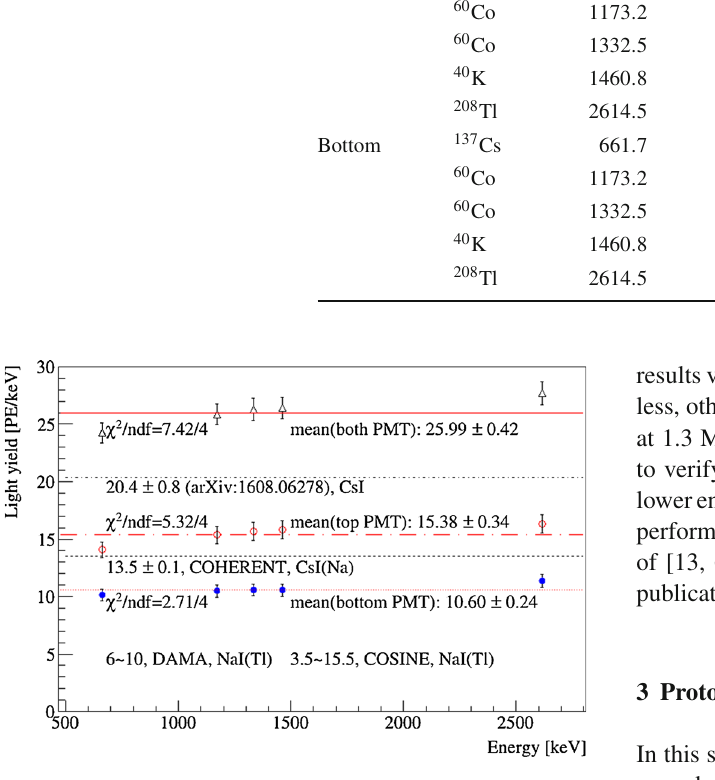
Fig. 9 The obtained light yields for the top (empty circles), the bottom (filled squares) and both (empty triangles) PMTs, compared to those achieved by other experiments [15,17,21] and an earlier measurement with a smaller crystal [49]